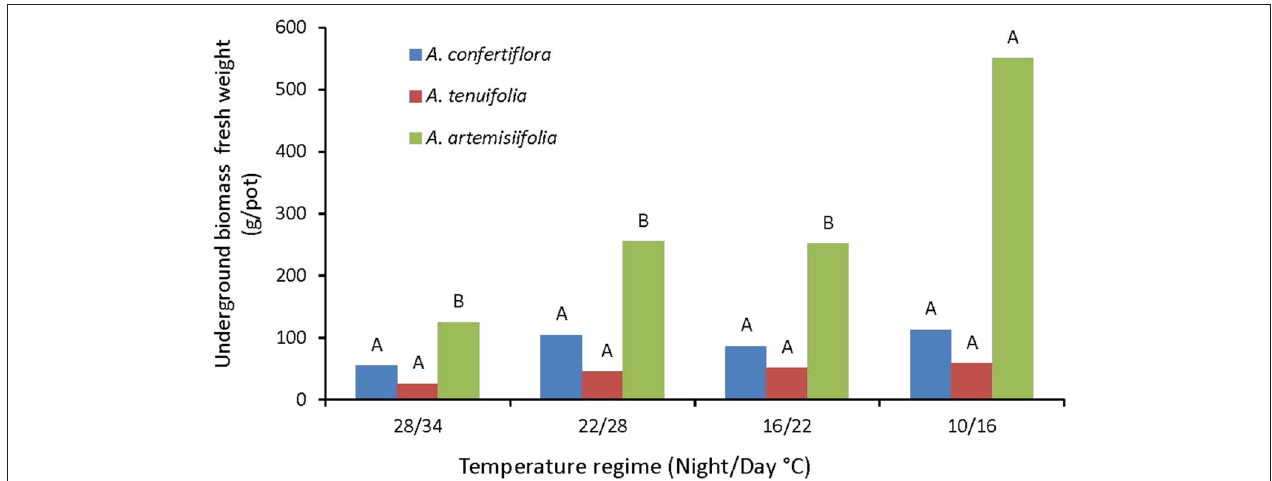
FIGURE 7 | The effect of temperature regimes on the underground biomass accumulation of A. confertiflora , A. tenuifolia, and A . artemisiifolia 121 DAS. Within a species (color), columns topped by different letters are significantly different according to Tukey Kramer HSD, p = 0.001.